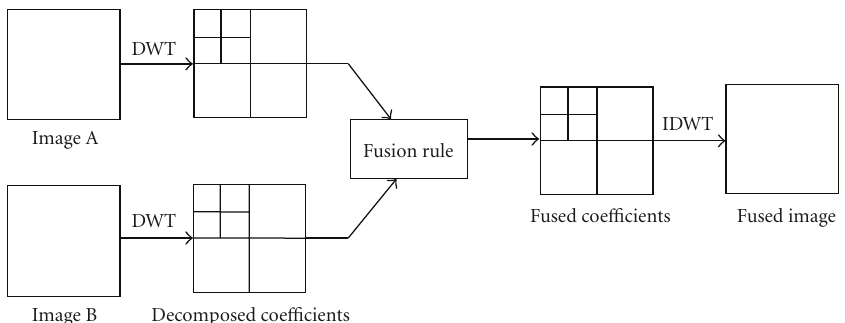
Figure 2: The image fusion scheme using the wavelet transform.